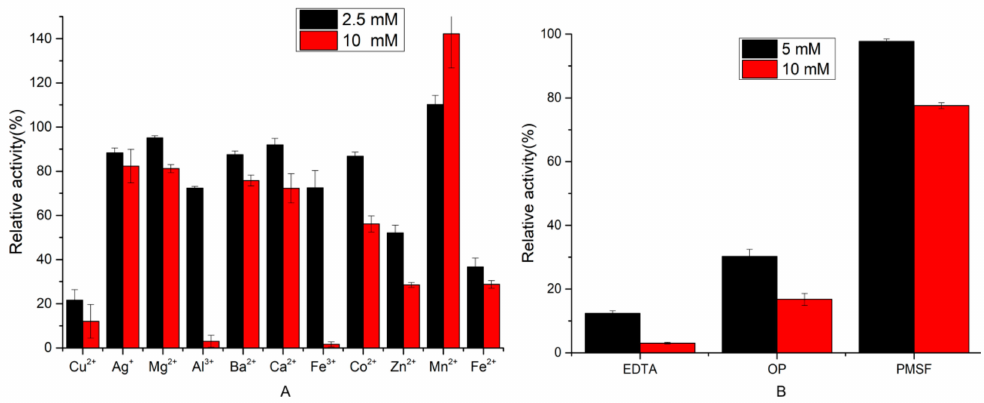
Figure 4. E ff ects of di ff erent metal ions ( A ) and di ff erent inhibitors ( B ) on protease activity. Values are expressed as the mean ± SD ( n = 3).